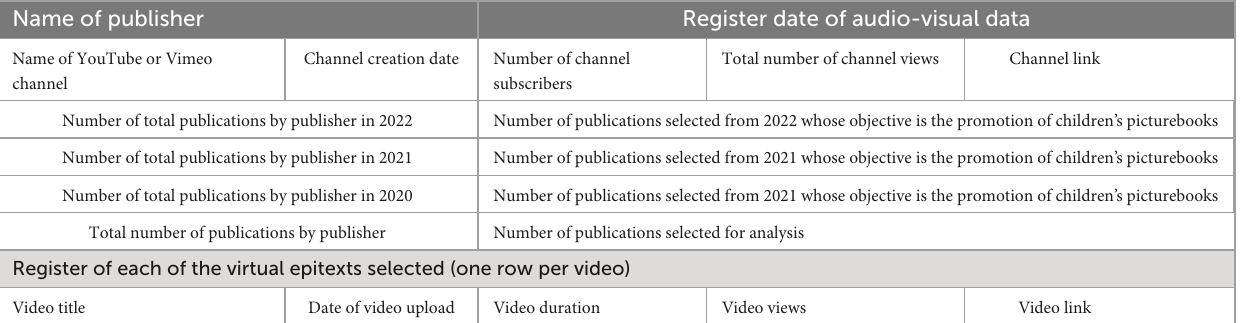
TABLE 4 Register sheet for audio-visual